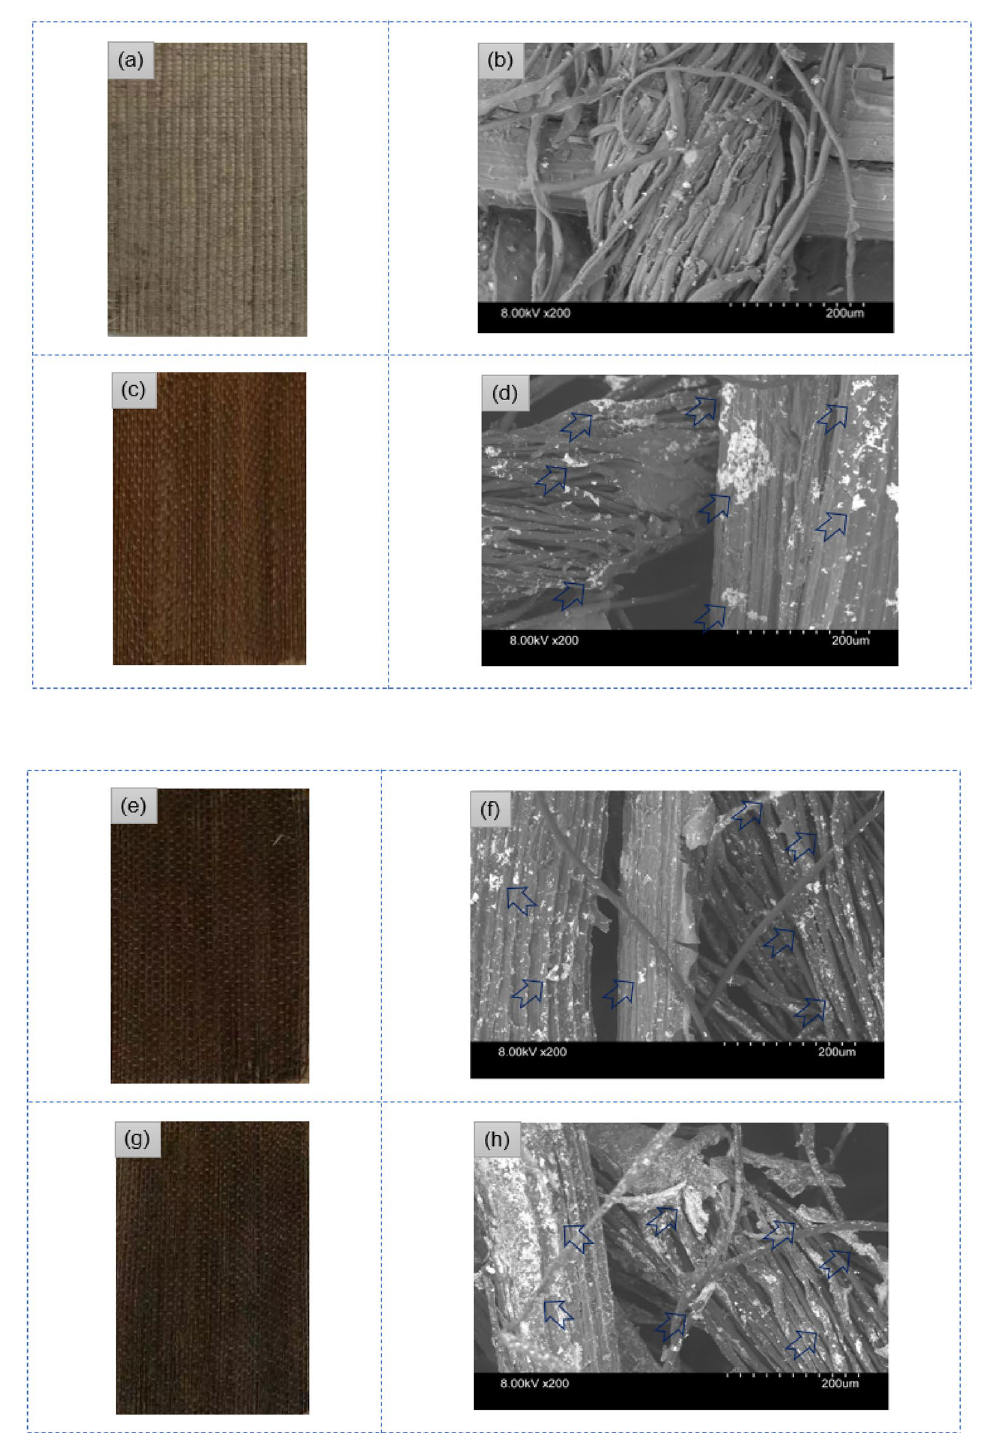
Figure 4. Physical photographs of control and nanosilver treated samples: ( a ) control sisal/cottons physical image, ( b ) control sisal/cottons morphological image, ( c ) physical image of EAg1, ( d ) morphological image of EAg1, ( e ) physical image of EAg2, ( f ) morphological image of EAg2, ( g ) physical image of EAg3, ( h ) morphological image of